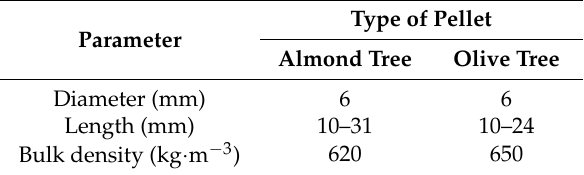
Table 1. Physical characteristics of pellets from almond and olive trees.